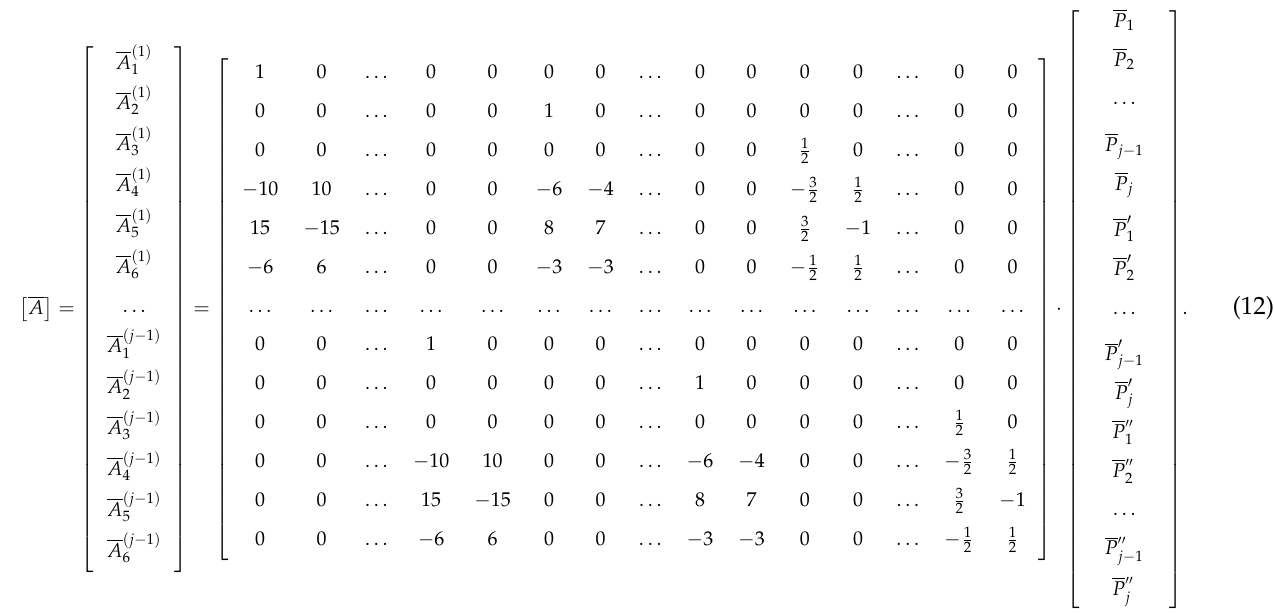
P , 1,...,4 j = of the con- j